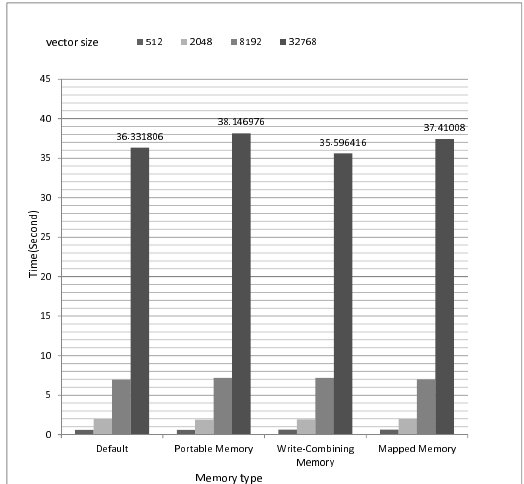
Fig. 16. GPU State Restoration Time